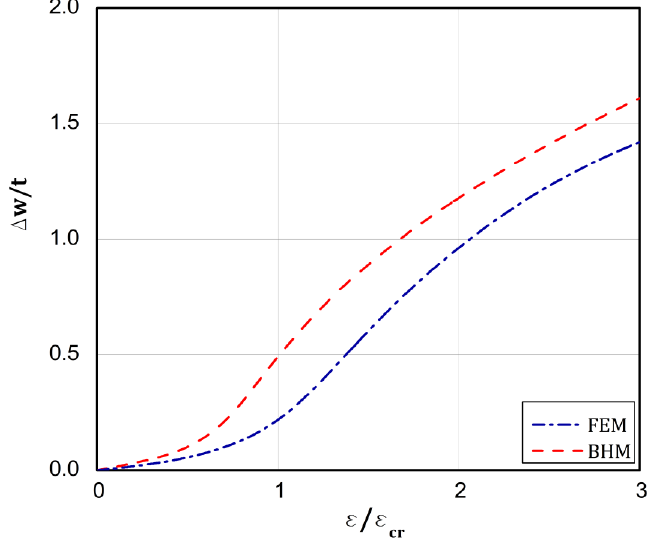
Figure 9. Dependence of ∆ w / t vs. ε / ε cr for variant A and type 4 of loads.